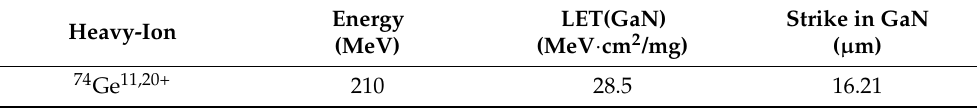
Figure 13. The heavy-ion accelerator of China Atomic Energy Research Institute. Table 1. Heavy ions used in the